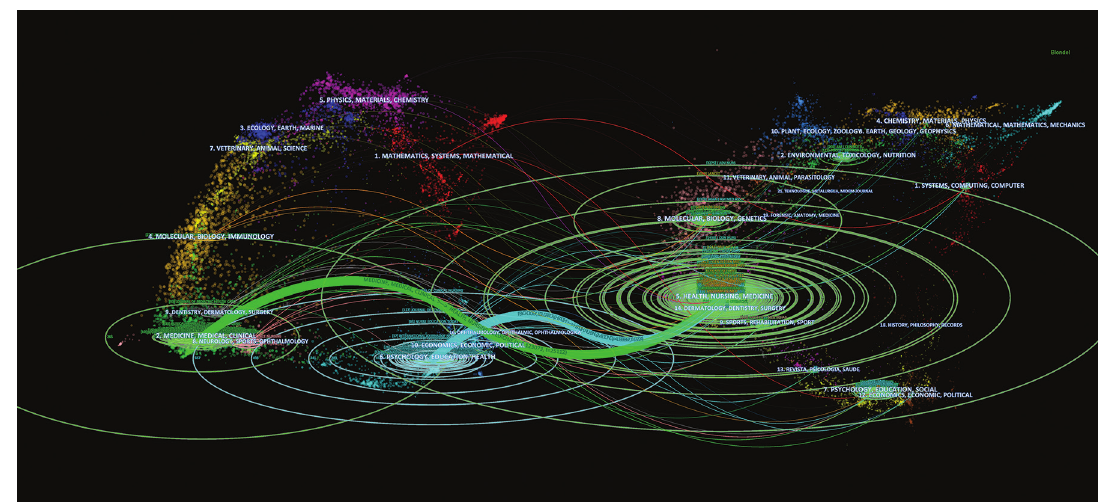
Figure 7. The knowledge transfer of nurse practitioners according to the Overlay Maps